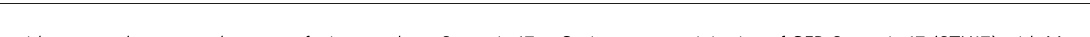
Fig. 6 BRUCE interacts with an autophagosome-lysosome fusion regulator Syntaxin 17. a Co-immunoprecipitation of GFP-Syntaxin 17 (STX17) with Myc- BRUCE. GFP-STX17 and Myc-BRUCE WT were transfected in HEK293T cells. Myc-BRUCE was immunoprecipitated using anti-Myc antibody from total cell lysates. Myc-BRUCE and GFP-STX17 were detected by western blotting, using the indicated antibodies. *Nonspeci fi c band. b Confocal microscopy images of Bruce + / + and Bruce − / − MEFs, stably expressing exogenous GFP-STX17. Cells were grown in fully supplemented medium (FM) or starved for 2 h (Starv) with or without Ba fi lomycin (Baf; 100 nM). Scale bars, 20 µ m. c Colocalization analysis of endogenous LC3B and exogenously expressed GFP- STX17. Bruce + / + and Bruce − / − MEFs stably expressing GFP-STX17 were grown in FM or starved for 2 h with or without Ba fi lomycin (100 nM), fi xed, and stained for endogenous LC3B. Line plots across 8 µ m distance (marked with arrows) exemplify degree of colocalization of GFP-STX17 and LC3B signals. Scale bars, 20 µ